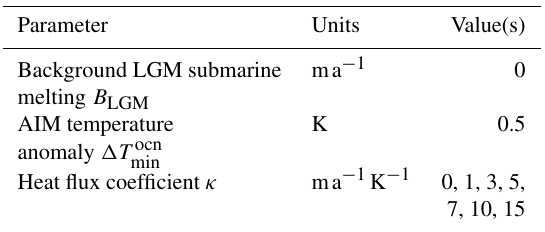
Figure 1. Simulated ice-sheet (a) surface elevation (in km) and (b) ice velocities (in ma − 1 ) after the spin-up procedure. The thick black line indicates the simulated grounding line position. The thick grey line represents the continental shelf break (depth 2000m). Table 1. Summary of the studied parameter values used in each sensitivity